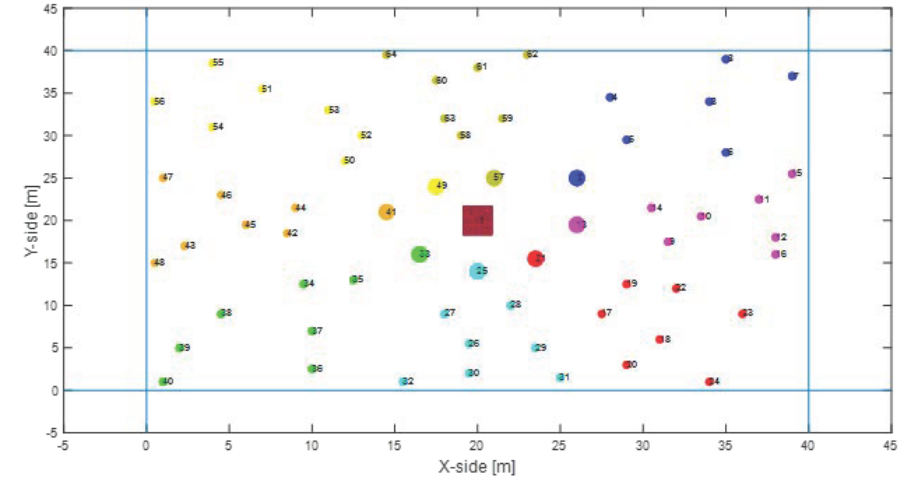
Figure 6. Random Mesh nodes deployment, where clusters are highlighted in different colours.